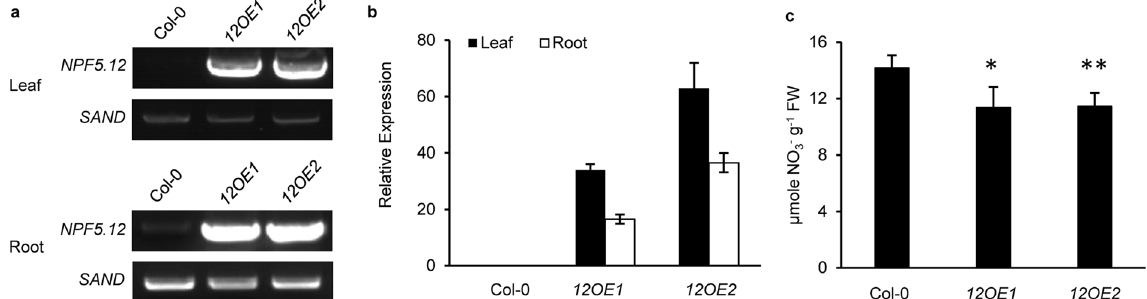
Figure 5. Decreased nitrate accumulation in roots of NPF5.12 overexpression lines. ( a , b ) Identification of NPF5.12 overexpression lines by RT-PCR ( a ) and quantitative PCR analysis ( b ). ( c ) 24 days old hydroponically grown plants were subjected to nitrogen-starvation for 30 h, then roots were sampled and nitrate contents were determined by HPLC. 12OE1 and 12OE2 were two independent NPF5.12 overexpression lines. Values are means ± SD, n = 5–7. Asterisks indicate difference between wild type and overexpression lines at P < 0.05 ( * ) and P < 0.01 ( ** ) by Student’s t